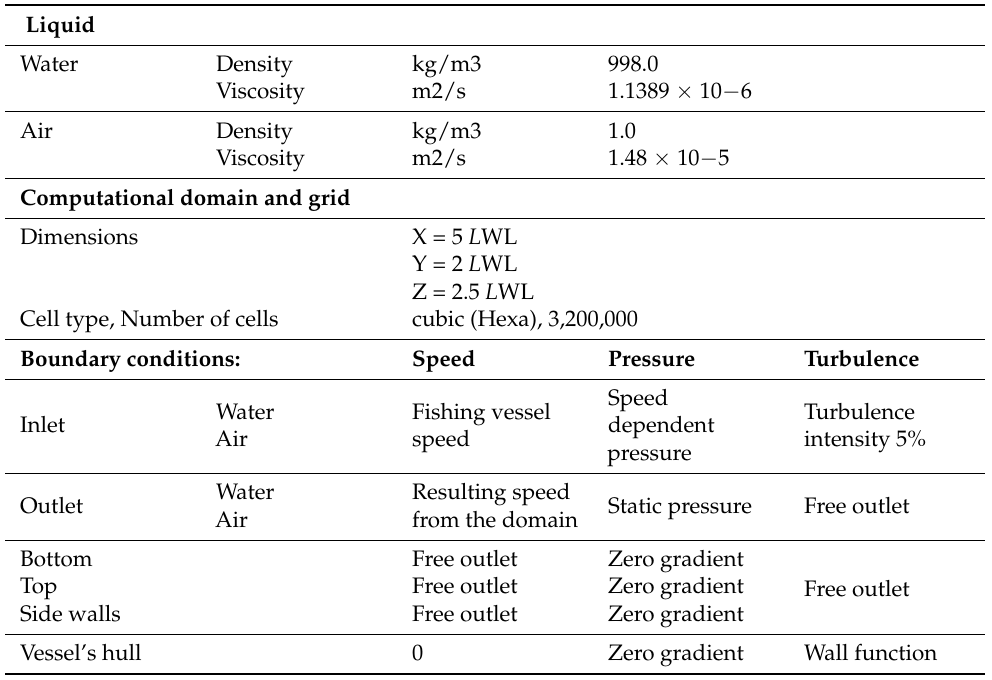
Table 2. Parameters for numerical